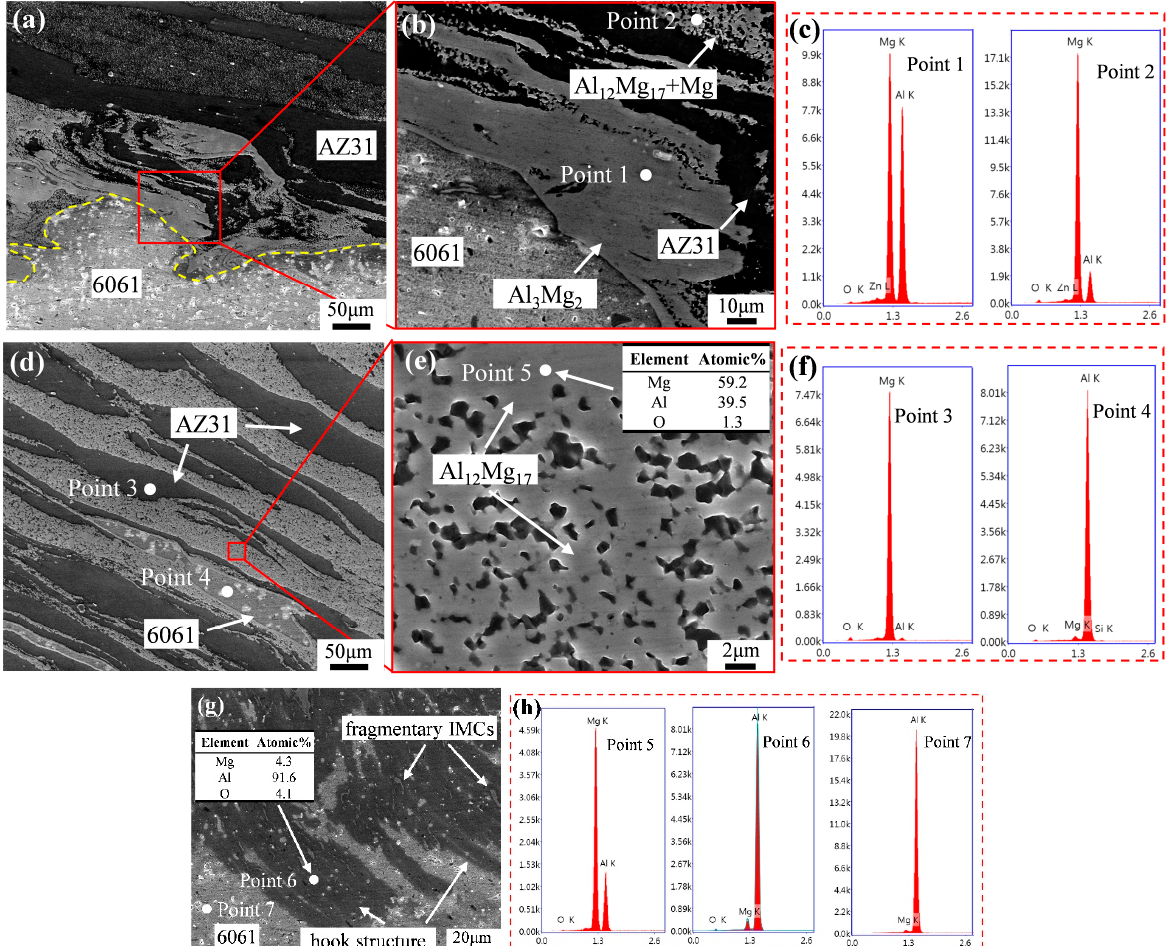
Figure 9. SEM morphology and EDS results of the joint welded in Configuration Mg-Al at 700 rpm: ( a ) interface of SZ bottom at the RS; ( b ) magnified micrograph of ( a ); ( c ) EDS results of points 1 and 2; ( d ) SZ; ( e ) magnified micrograph of ( d ); ( f ) EDS results of points 3 and 4; ( g ) hook structure at SZ bottom at the AS; ( h ) EDS results of points 5, 6 and 7.